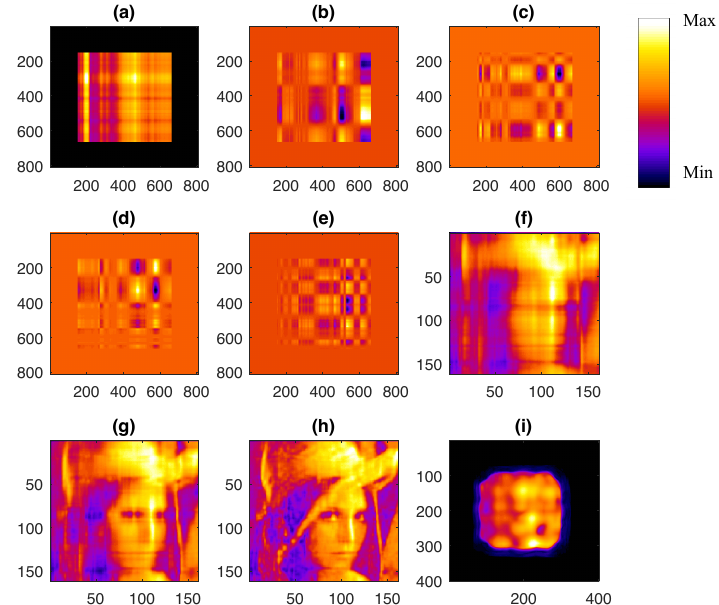
Figure 7. Five first fundamental modes ( a – e ) from SVD of a real-only Lena image; ( f – h ): simulated sum of 5 modes; 10 modes and 20 modes. (superposition of central part of mode Figure 7a–e); ( i ) reconstructed sum of 5 modes of object. (superposition of central part of mode Figure 7a–e); The colormap is the same as that in Figure 6. The Figure 7i is reconstructed results of Figure 7f. The minima and maxima of colormap legend bar for Figure 7a–i are as follows respectively: [0, 0.7764]; [ − 0.3369, 0.3452]; [ − 0.3694, 0.3241]; [ − 0.3410, 0.3031]; [ − 0.3161, 0.3273]; [0.6184, 6.0942]; [0.5684, 6.1781]; [0.5845, 6.3456]; [0,